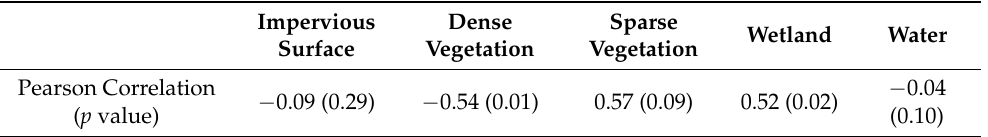
Impervious Dense Sparse Wetland Water Surface Vegetation Vegetation